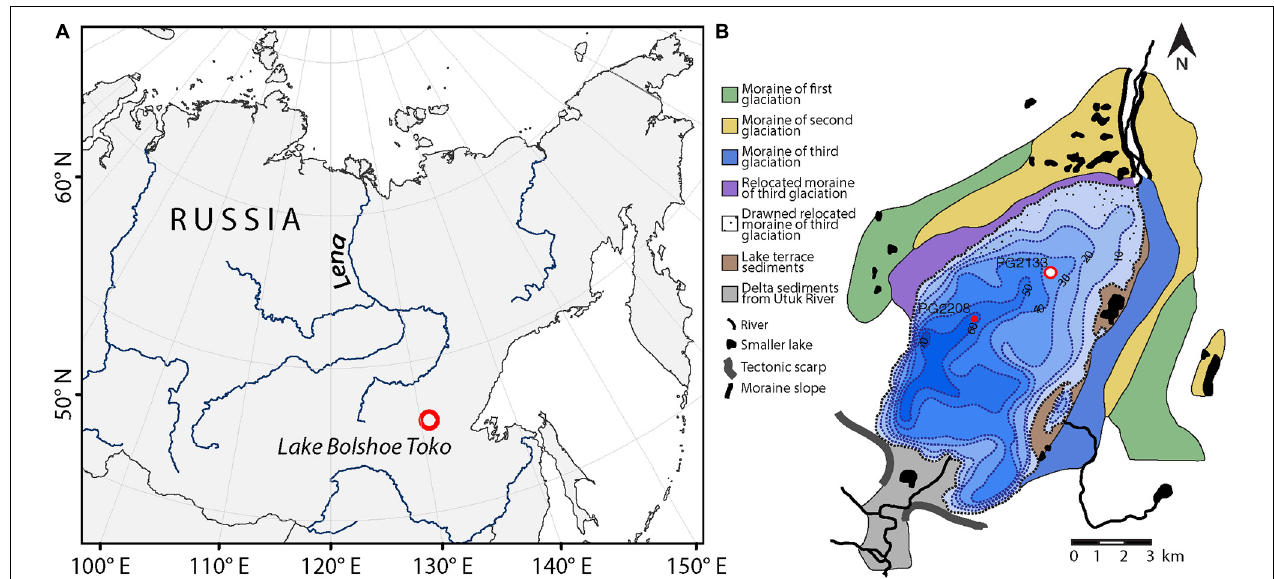
FIGURE 1 | Study area. (A) Location of Lake Bolshoe Toko in southeastern Yakutia, Siberia. (B) Bathymetrical map with geological information and position of the sediment core PG2133 used for vegetation analyses in the northern part of the basin. Sediment core PG2208 was used to correlate Holocene ages between cores.